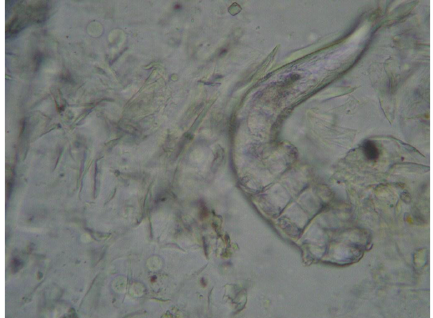
Figure 3: Scraping containing Demodex mites (40X).